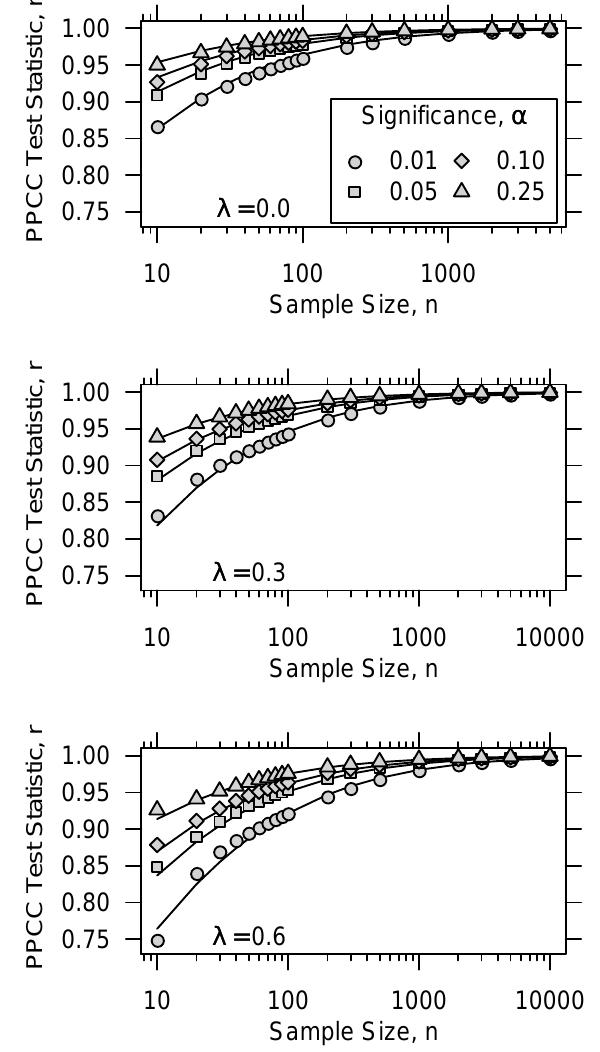
Fig. 2. Comparison of regression (solid line) and simulated val- ues of the censored Gumbel PPCC = r values for various values of significance level α , censoring level λ , and sample size n